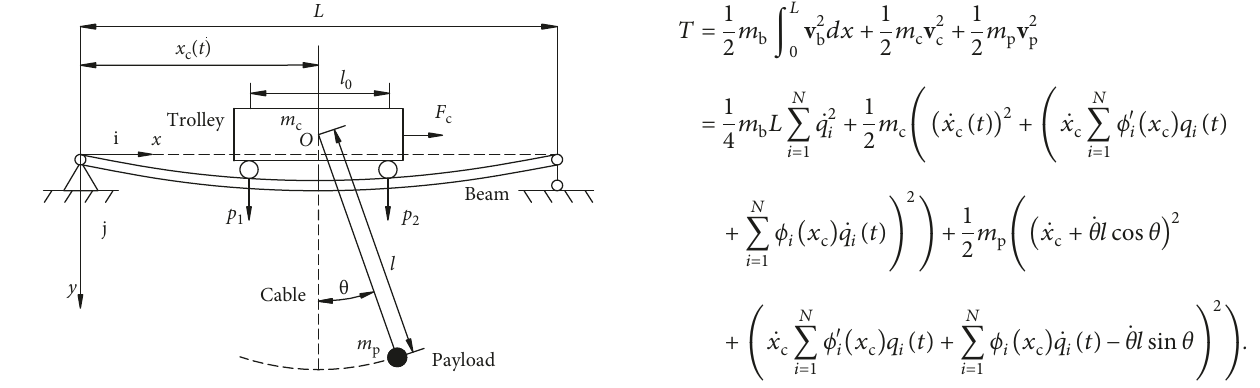
Figure 1: Sketch of an underactuated overhead crane